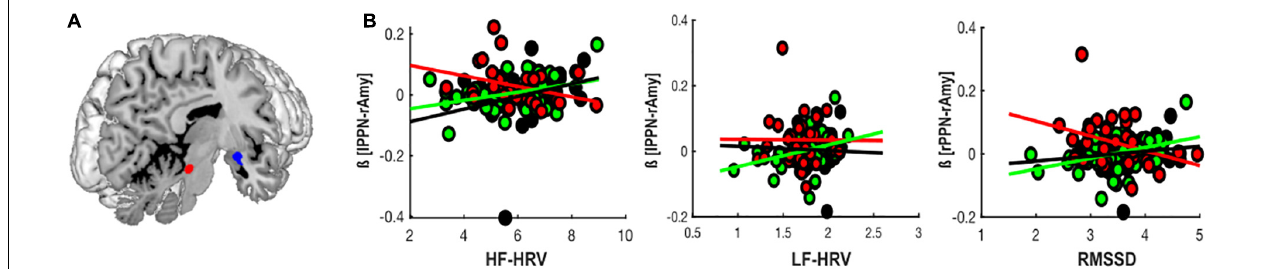
FIGURE 1 | Group-differences in PPN rsFC with CAN-related brain regions associated with HRV. (A) Group-differences in PPN (see region highlighted in red) rsFC with limbic brain regions (i.e., the right amygdala and the parahippocampal gyrus in blue) associated with HF-HRV and RMSSD. (B) Correlation of beta-values extracted from the peak voxel of the identified group difference in PPN rsFC with limbic brain regions and HF-HRV, LF-HRV, and RMSSD in controls (black), PTSD (green), and PTSD + DS (red), respectively. Amy, amygdala; HF-HRV, high-frequency heart rate variability; LF-HRV, low-frequency heart rate variability; lPPN, left peduncolopontine nuclei; RMSSD, root-mean square of successive